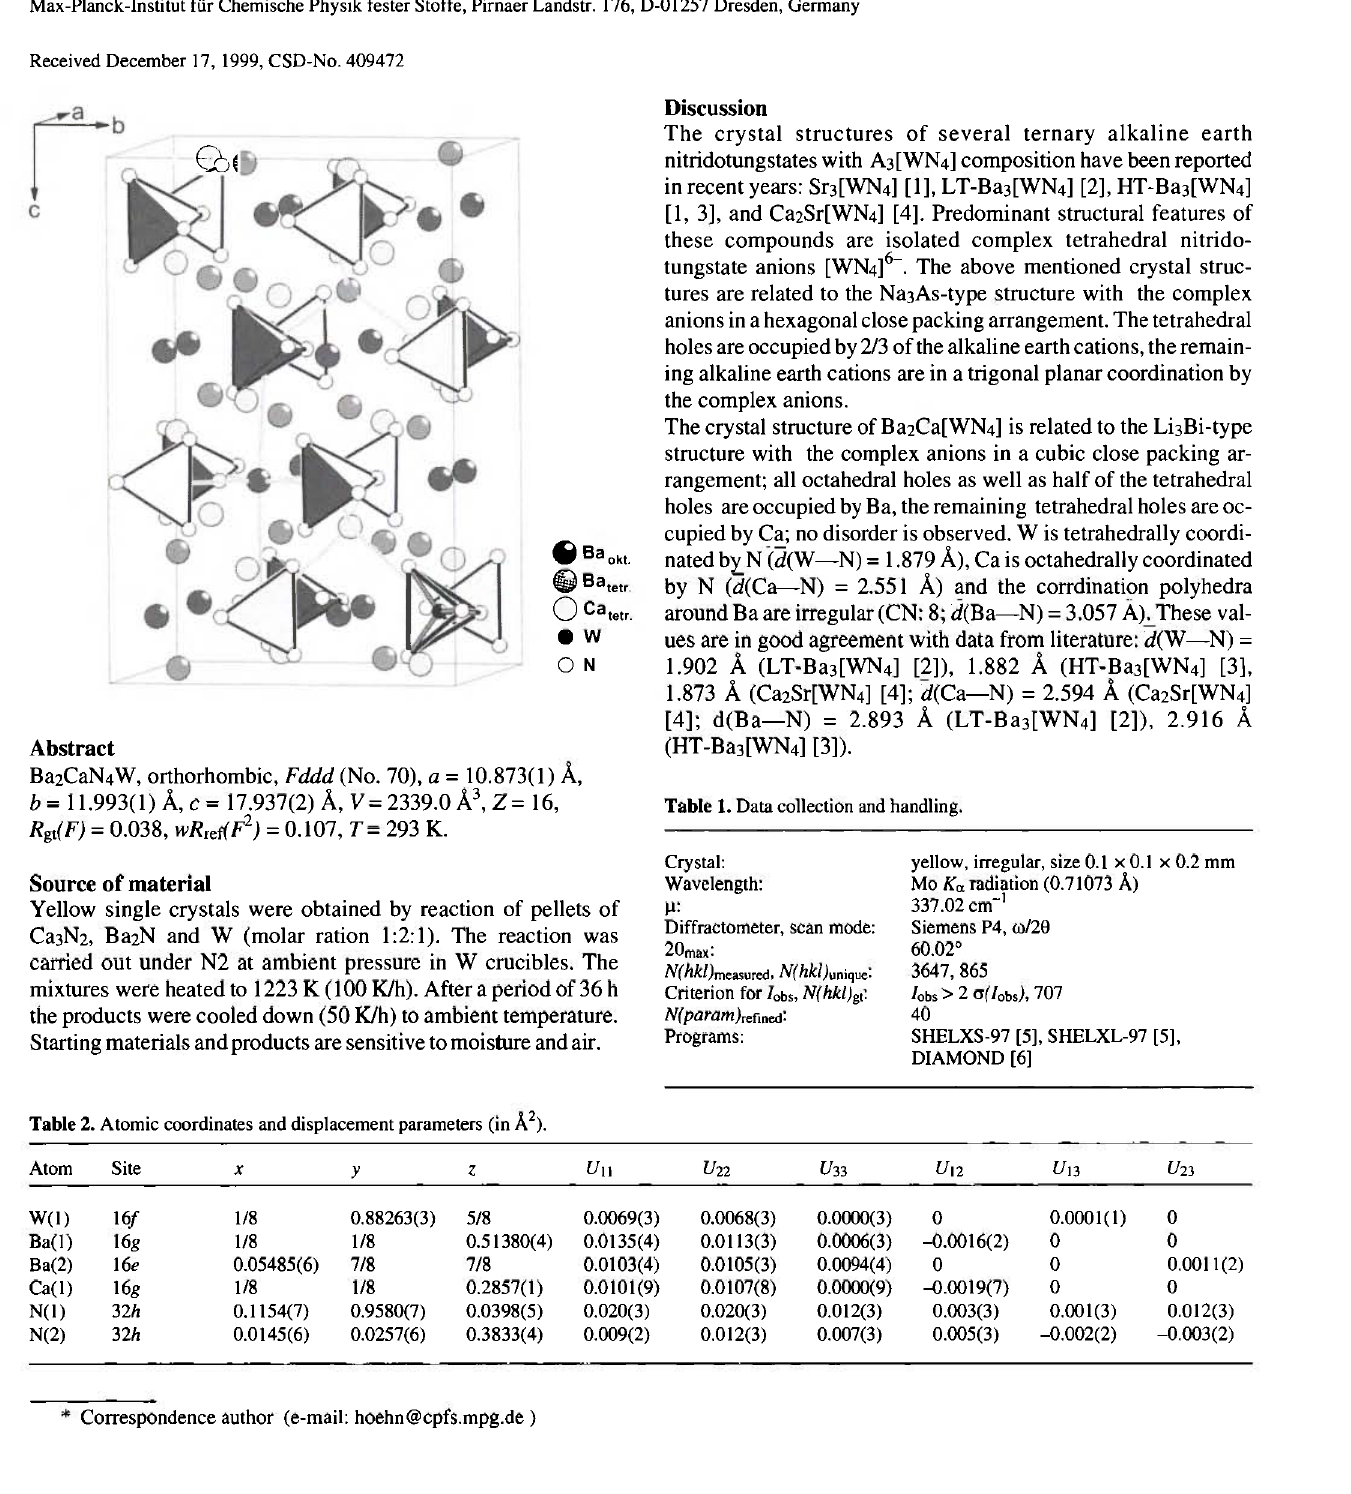
Table 2. Atomic coordinates and displacement parameters (in Ä 2 ).